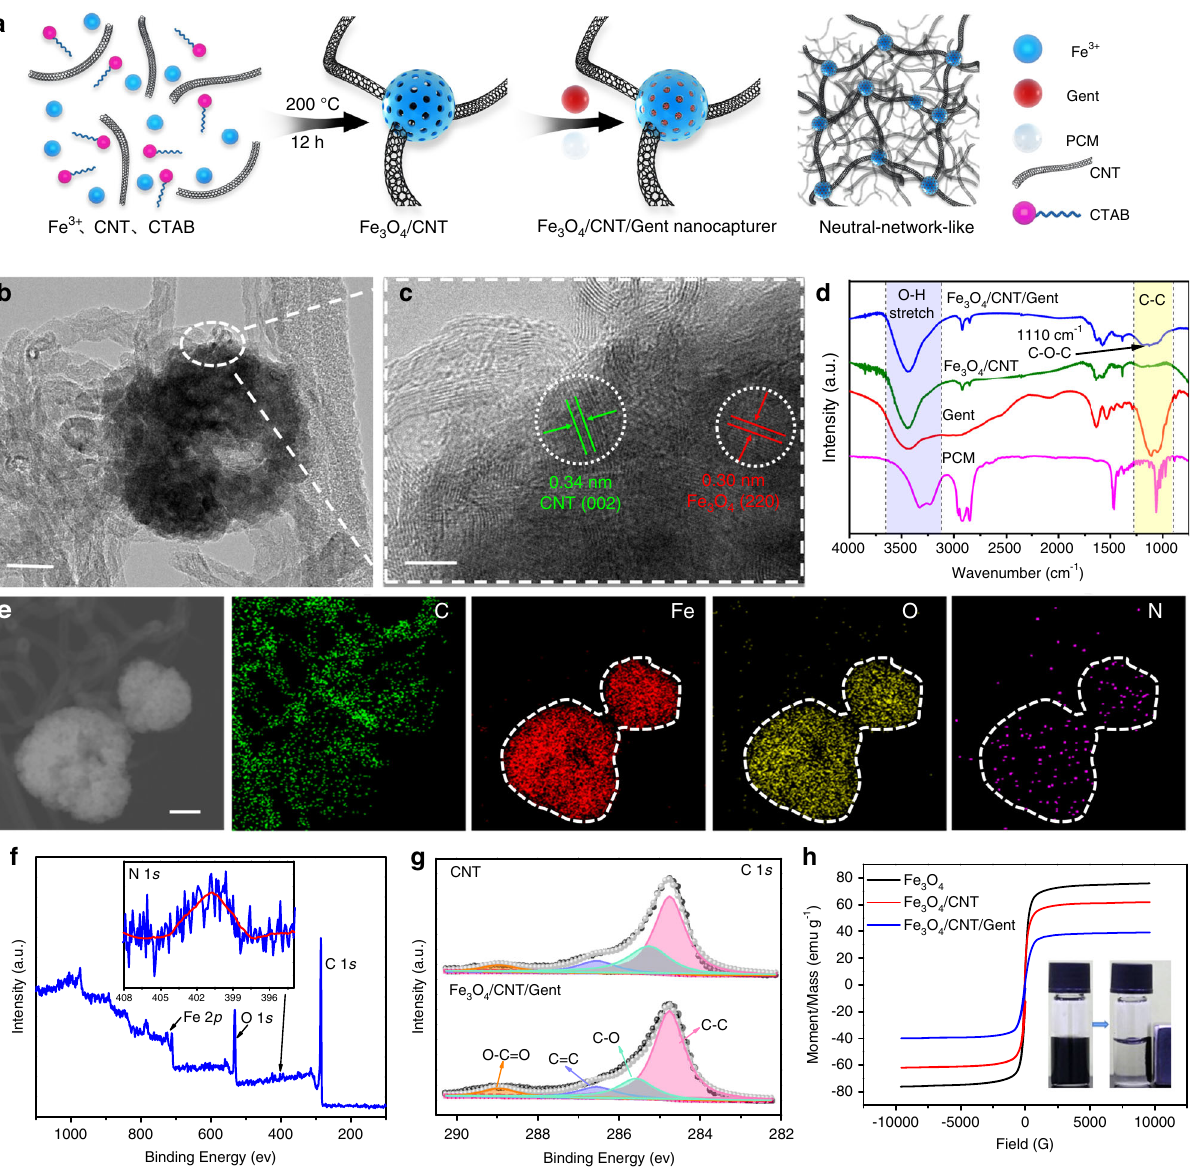
Fig. 2 Characterization of the synthesized Fe 3 O 4 /CNT/Gent nanocapturer. a Schematic illustration of the preparation procedures of the Fe 3 O 4 /CNT/ Gent nanocapturer. Typical TEM ( b ) and HRTEM ( c ) images of the Fe 3 O 4 /CNT/Gent nanocapturer. Scale bar, 25 nm ( b ) and 5 nm ( c ). d FTIR spectra of the Gent, PCM, Fe 3 O 4 /CNT, and Fe 3 O 4 /CNT/Gent. e TEM element mapping of Fe 3 O 4 /CNT/Gent. Scale bar, 50 nm. f The XPS curves of Fe 3 O 4 /CNT/ Gent. Inset: magni fi ed XPS curves of N 1 s . g The C 1 s XPS spectra in CNT and Fe 3 O 4 /CNT/Gent. h The magnetic properties of Fe 3 O 4 , Fe 3 O 4 /CNT, and Fe 3 O 4 /CNT/Gent. Inset: the photograph showing the ferro fl uidic behavior of Fe 3 O 4 /CNT/Gent in physiological saline. Neodymium rare earth permanent magnet with grade N38 magnetic energy, around 30 mm × 20 mm × 10 mm in length, width, and height, respectively. Source data are provided as a Source Data fi